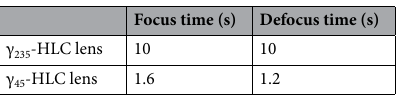
Table 1. Calculated focus and defocus times of the HLC